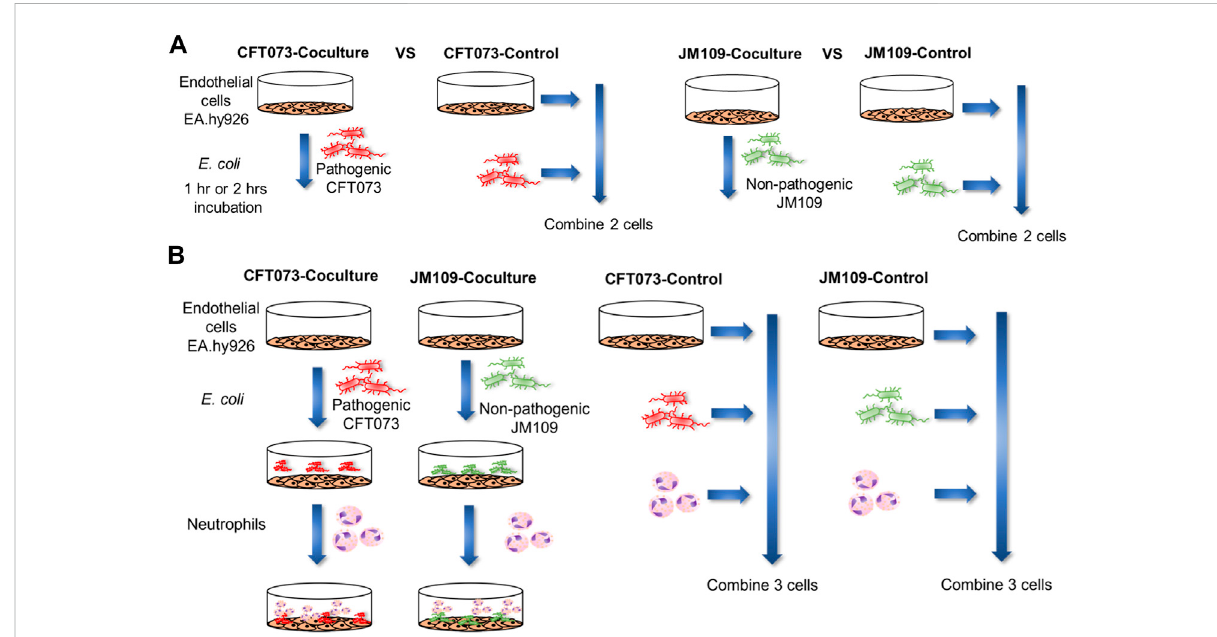
Schematic illustration of the work fl ow for coculture lipidomics. (A) 2 cell system: EA hy.926 cells (EA) were exposed to 20 × 10 6 of either CFT073 orJM109 E. coli for 1 or 2 hat 37 ° C. The cell ratio of EA: E. coli was 1:20.Control samples for thissystem wereprepared by combining E. coli , and EA cells that were incubated separately. (B) 3-cell system: EA cells were exposed to 20 × 10 6 of either CFT073 or JM109 E. coli for 1 h at 37 ° C. Subsequently, 2 × 10 6 neutrophils were added and further incubated for 1 h at 37 ° C. The cell number ratio of EA: E. coli :neutrophils was 1:20:2. Control samples were prepared by combining E. coli , neutrophils and EA cells that were incubated separately. At the end of incubation, cells and media were collected for lipidomic